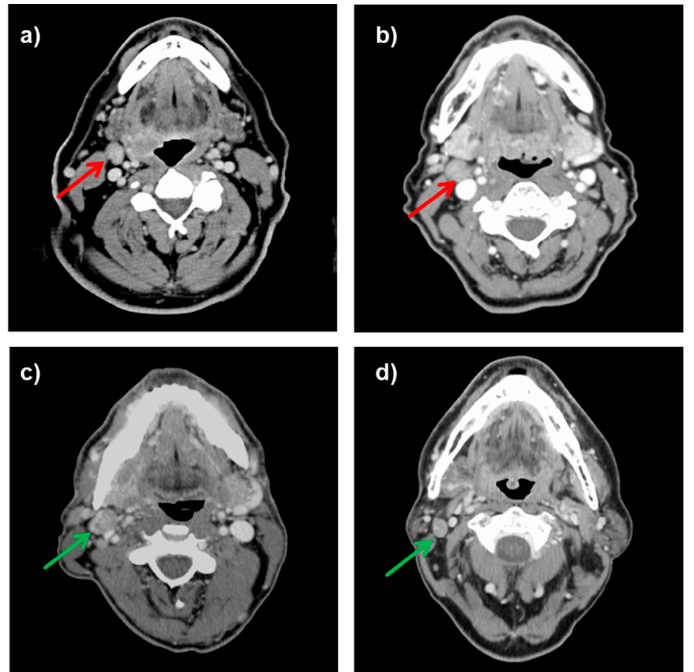
Figure 1. Axial contrast-enhanced CT scans of HNC patients clinically staged as neck lymph node positive who were histopathologically negative and who could be rejected from postoperative irradiation (upper row). In the lower row, CT scans of patients who were actually histopathologically positive and who had postoperative irradiation (lower row). Red arrow indicates cervical lymph node overstaging. Green arrow indicates true positive lymph node staging: ( a ) A 62-year-old male patient with a cT2cN2bcM0 oropharyngeal cancer treated with lateral pharyngotomy and neck dissection; ( b ) A 61-year-old female patient with a cT2cN2bcM0 supraglottic laryngeal cancer treated with transoral resection and neck dissection; ( c ) A 54-year-old male patient with a cT2cN2bM0 (pT2pN1) oropharyngeal cancer treated with transoral resection, neck dissection and PORT; ( d ) A 57-year-old male patient with a cT2cN2cM0 (pT2pN2c) supraglottic laryngeal cancer treated with transoral resection, bilateral neck dissection and PORT.